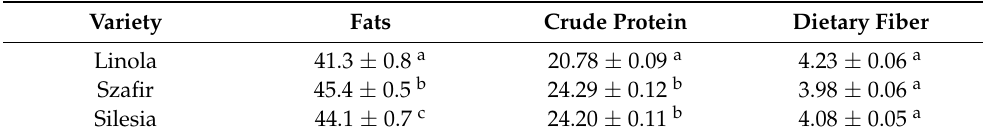
Table 4. Seed protein, oil content and dietary fiber amount of linseed (%) depending on variety. All results are statistically significant ( p < 0.05). Different superscripts imply significant differences.